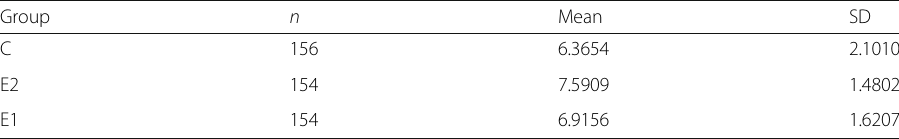
Table 8 The combined mean for Material 1 Group n